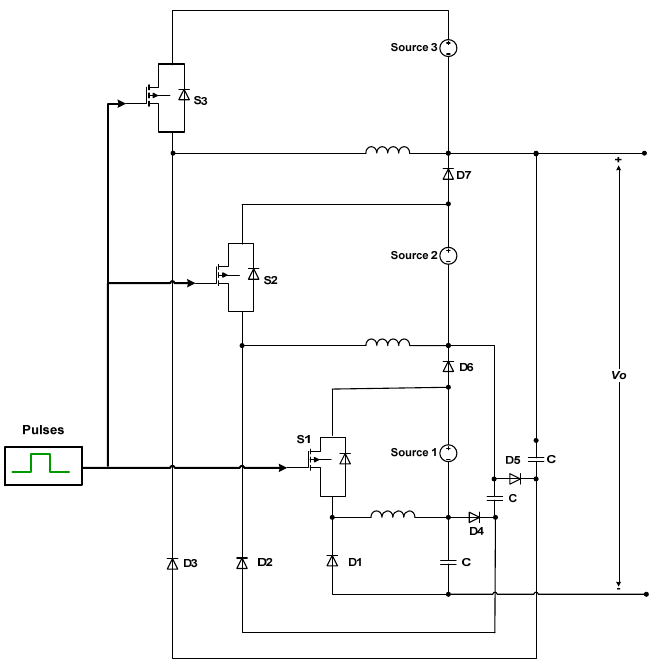
Figure 12. Suggested buck-boost DC–DC converter supplied from three DC sources.